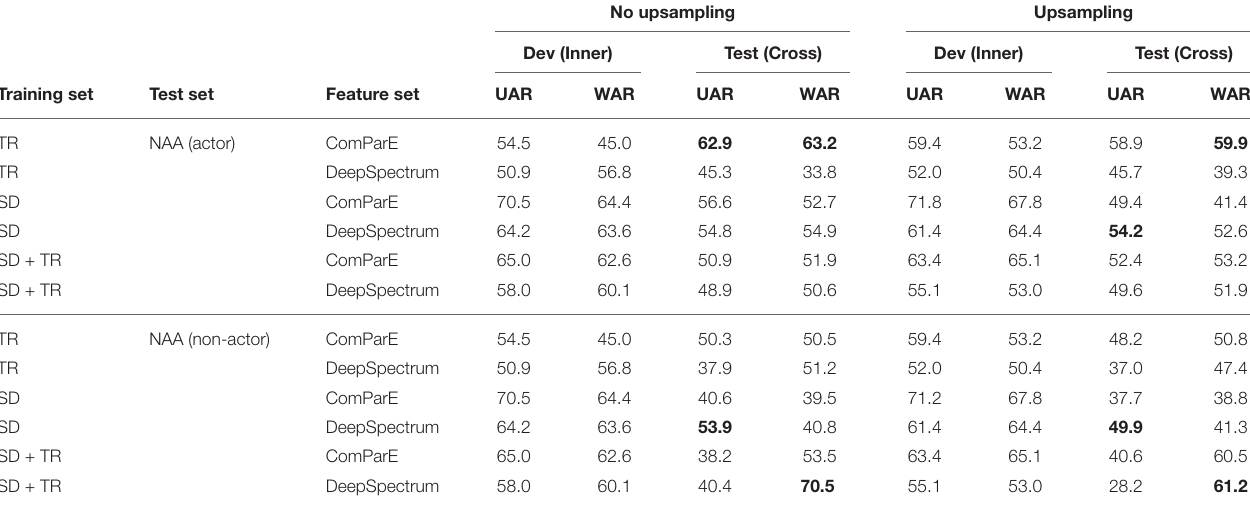
TABLE 6 | Results obtained for all corpora combinations where NAA is used as the testing set using the NAA N-A label. No upsampling Upsampling